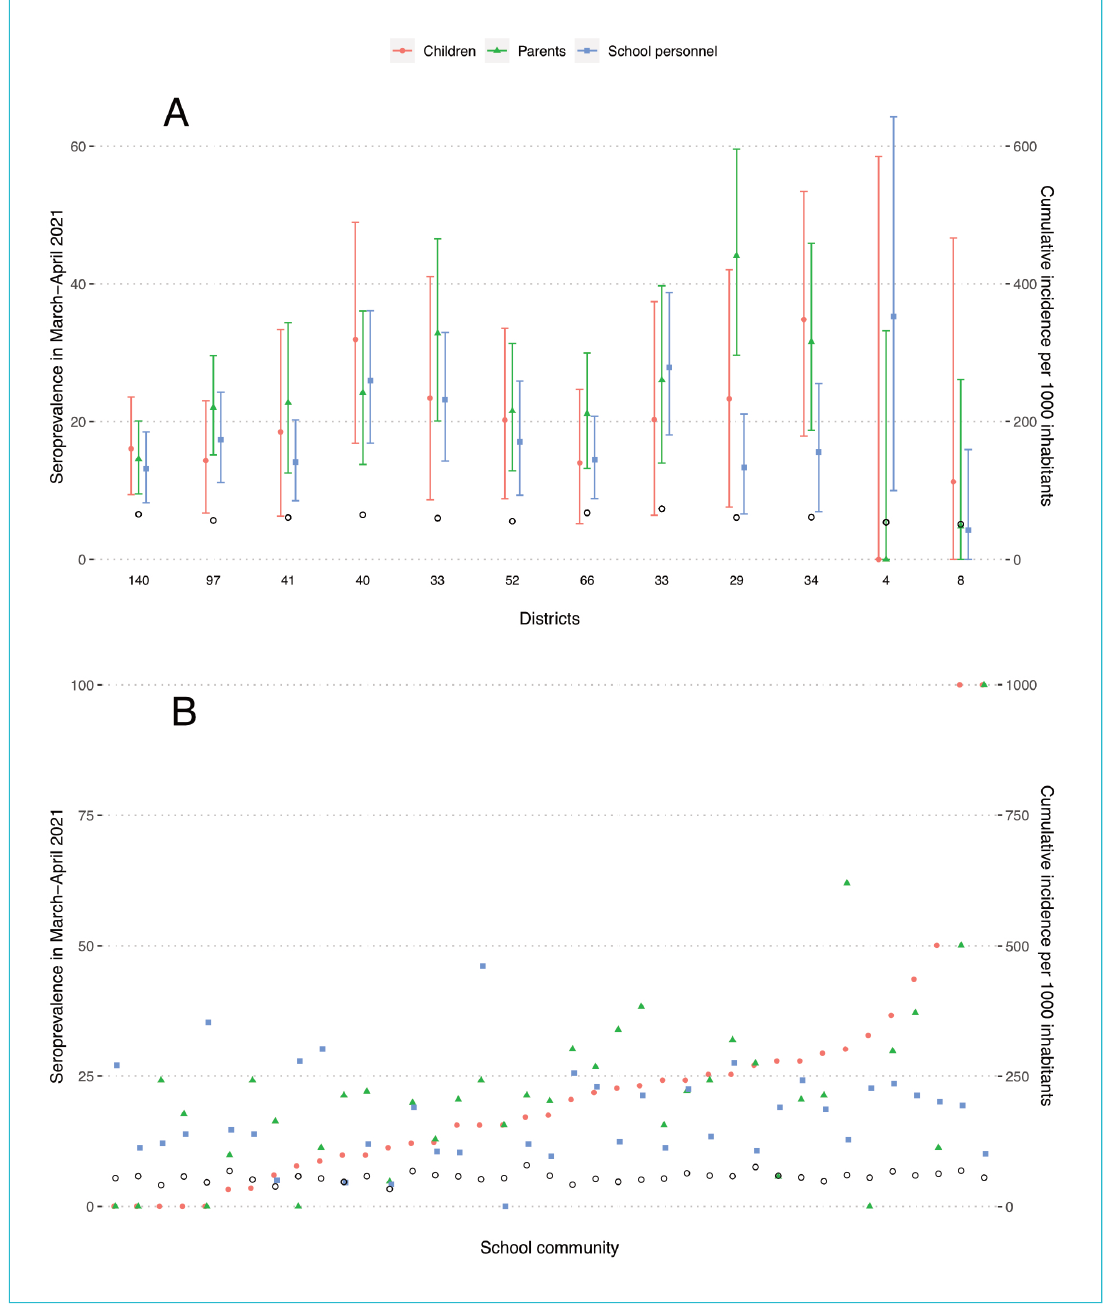
Figure S3: Seroprevalence in children, parents and school personnel and cumulative incidence of the population in the canton of Zurich, Switzerland, in March-April 2021. Only children and parents from families in which both parents were tested are included. A – within the can- tonal districts, B – within school communities Empty black circles represent cumulative incidence of laboratory-confirmed SARS-CoV-2 infec- tions among inhabitants of the district. At the bottom of figure 1A are numbers of children tested within the district. Districts and school commu- nities are ordered by increasing seroprevalence in